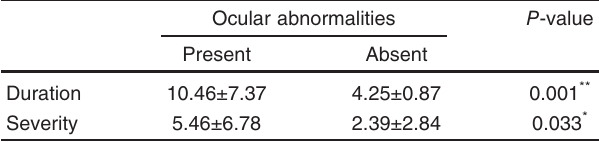
Table 8 Distribution of ocular abnormalities in vitiligo patients according to disease duration and severity Ocular abnormalities